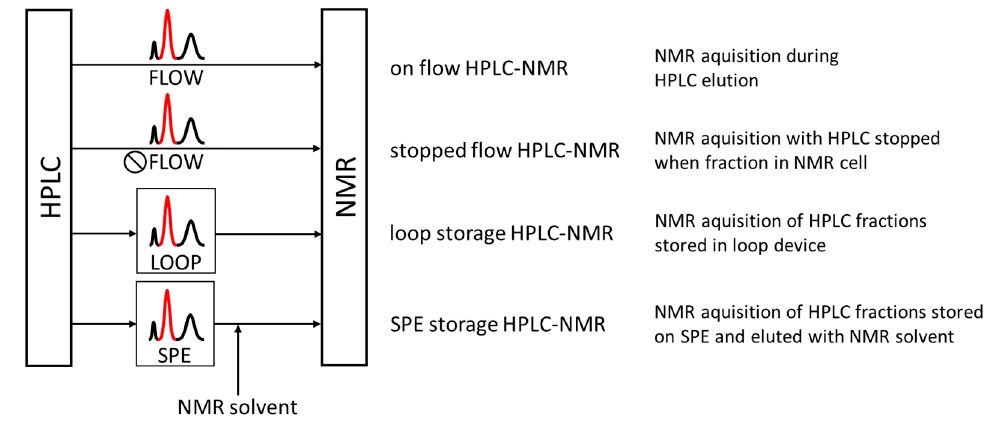
Figure 1. Illustration of the HPLC/NMR coupling modes. Direct coupling includes “on flow” and “stopped flow” setups, and indirect coupling makes use of the physical separation of chromatographic peaks in the mobile phase (“loop storage”) or on solid phases (“SPE storage”). Only in solid phase trapping, the HPLC mobile phase can be replaced with NMR solvent.